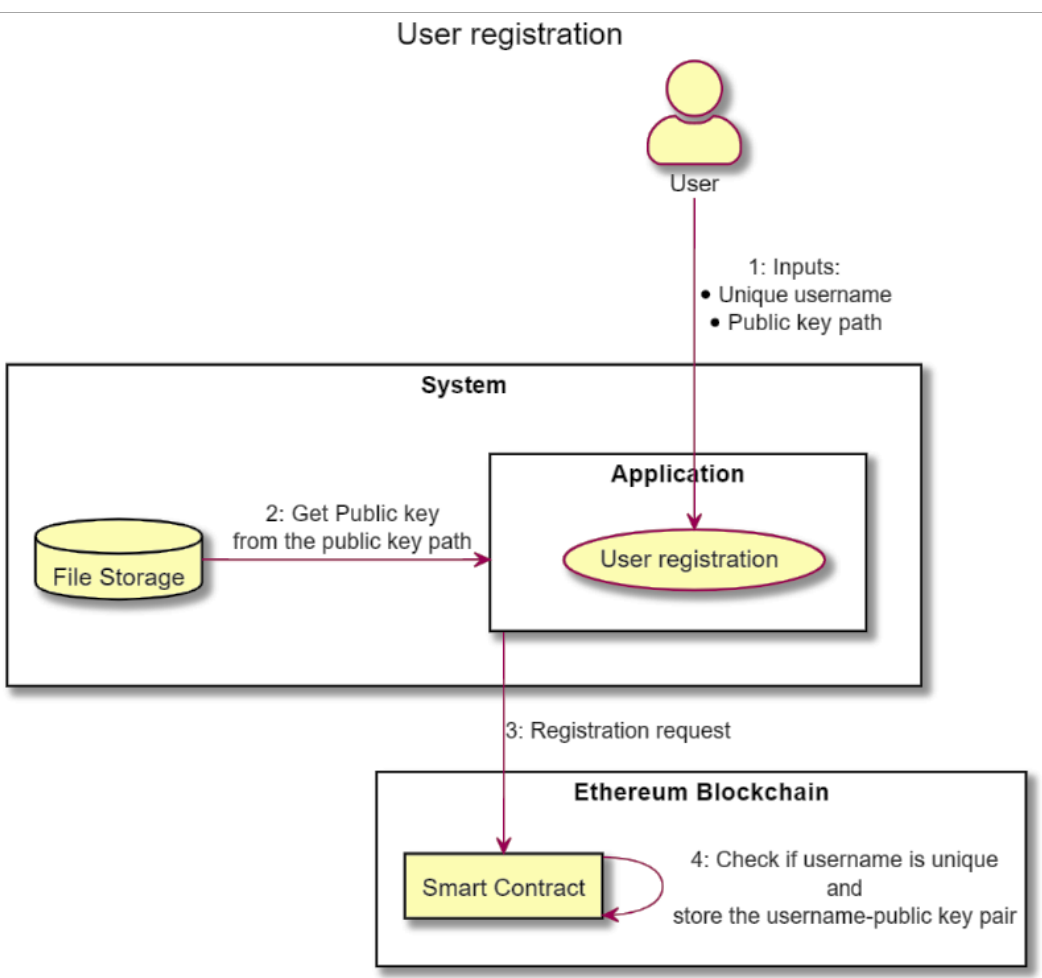
Figure 4. Flowchart of “User